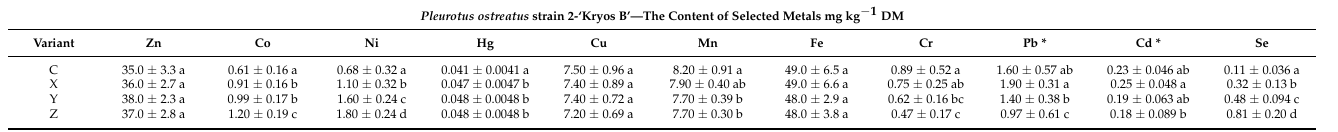
Table 6. Average metals content (mg kg − 1 DM) in samples of fortified fruiting bodies with selenium.